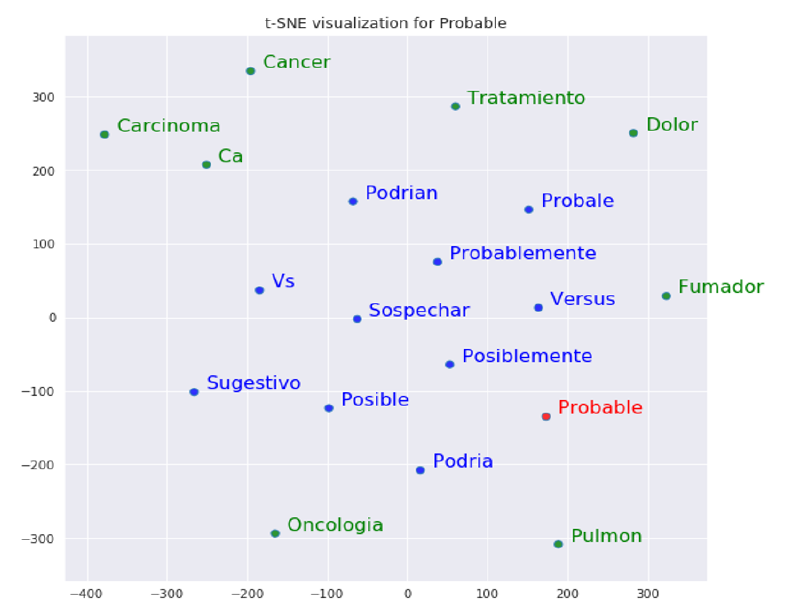
Figure 5. Related words to the cue